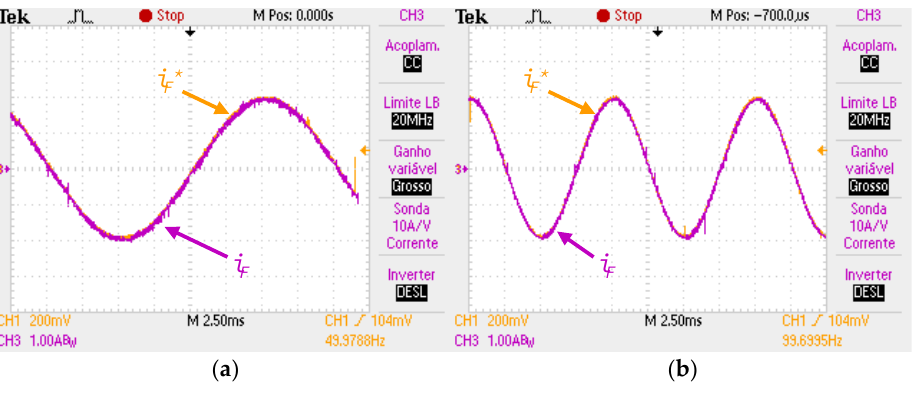
Figure 25. Experimental validation of the predictive current control algorithm producing a sinusoidal current with 2 A of amplitude: ( a ) Sinusoidal current with 50 Hz frequency; ( b ) Sinusoidal current with 100 Hz frequency.